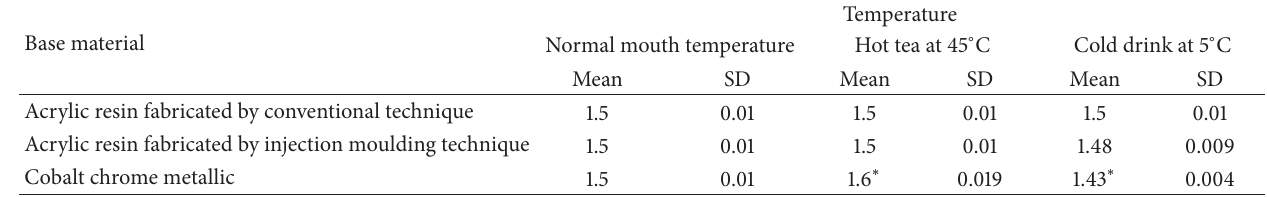
Table 3: The dimensional changes of the three denture base materials by temperature changes (after one month of denture insertion). Base